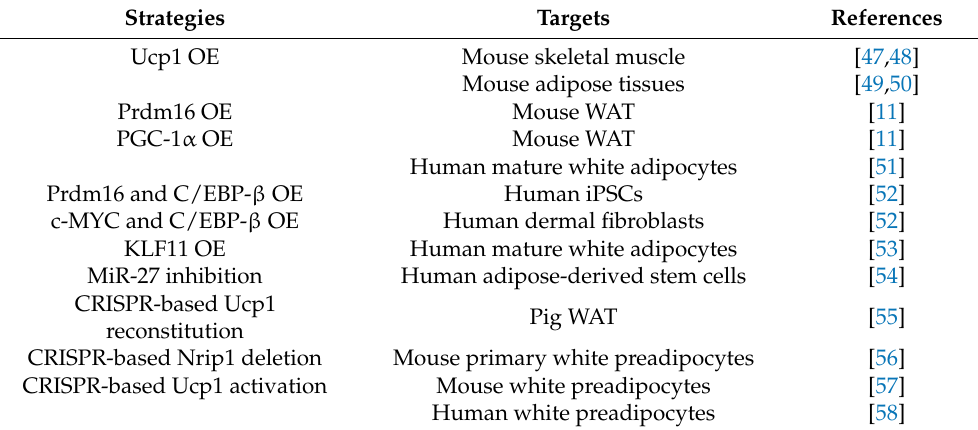
Table 2. Generation of thermogenic adipocytes by gene-based strategies in mice and